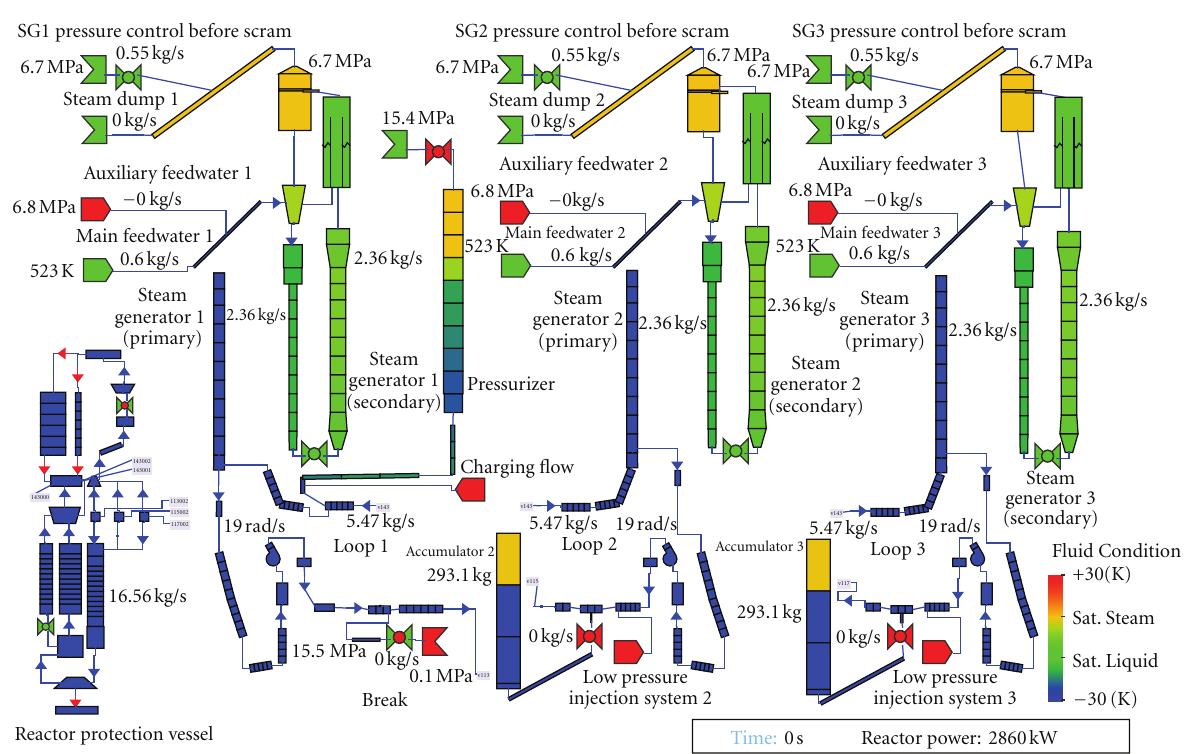
Figure 5: TRACE initial and boundary conditions for BETHSY 6.2TC test—animated